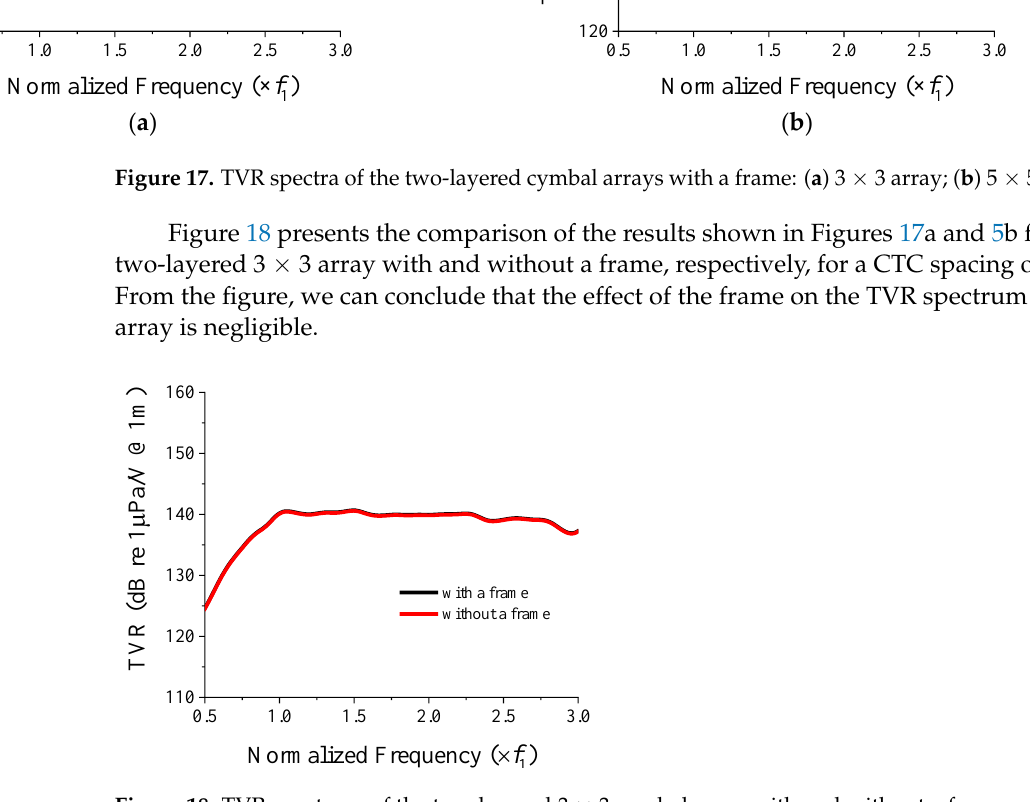
Figure 18. TVR spectrum of the two-layered 3 × 3 cymbal array with and without a frame. The fabricated prototypes of the two-layered 3 × 3 and 5 × 5 arrays with frames are shown in Figure 19.